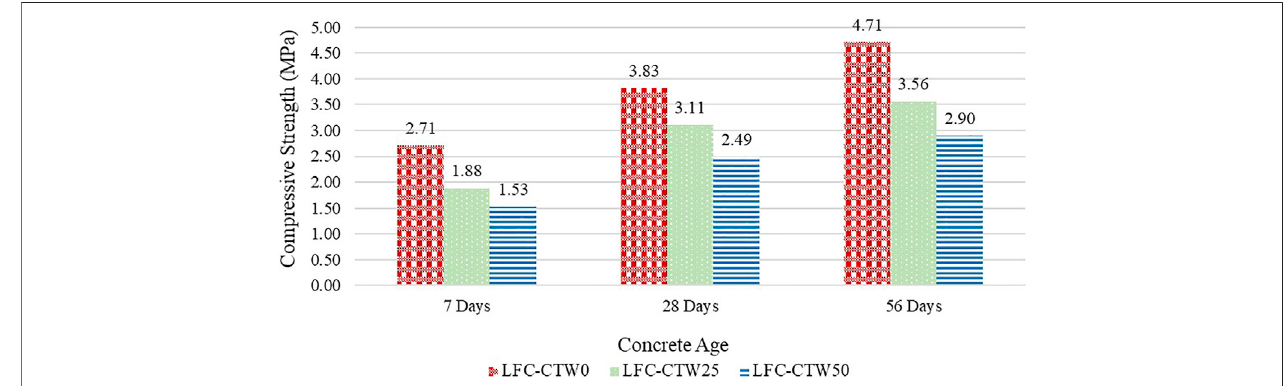
FIGURE 6 | Compressive strength of LFC-CTW0, LFC-CTW25, and LFC-CTW50 at ages of 7, 28, and 56 days.